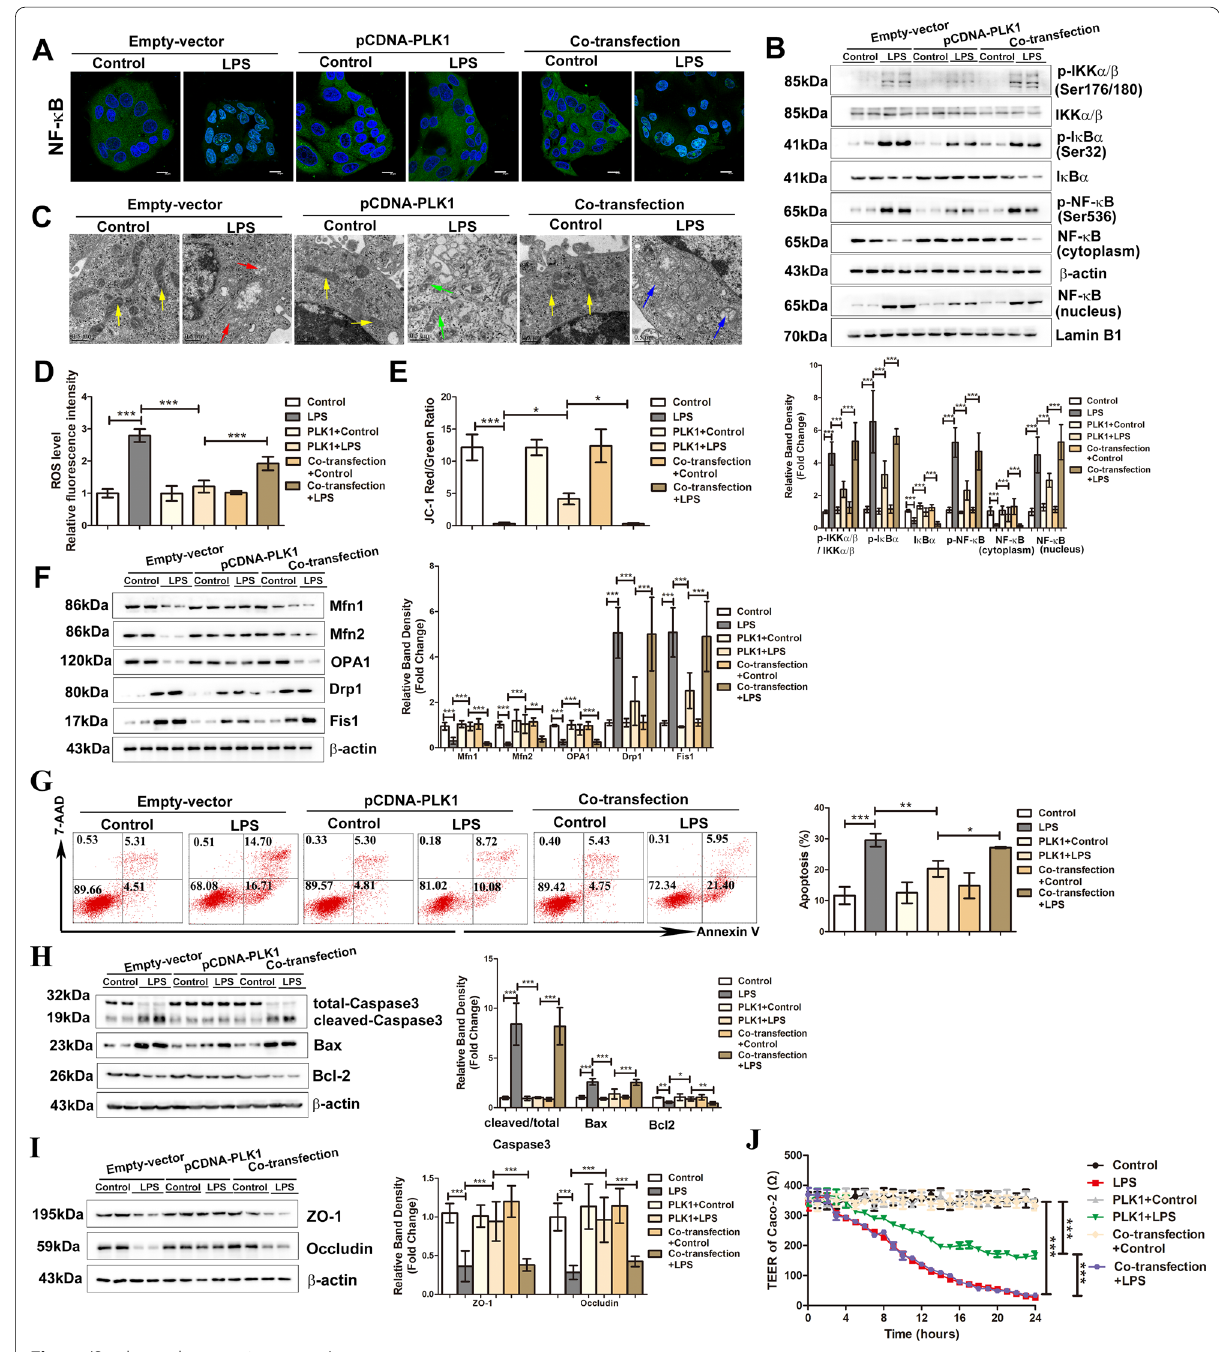
Fig. 7 (See legend on previous